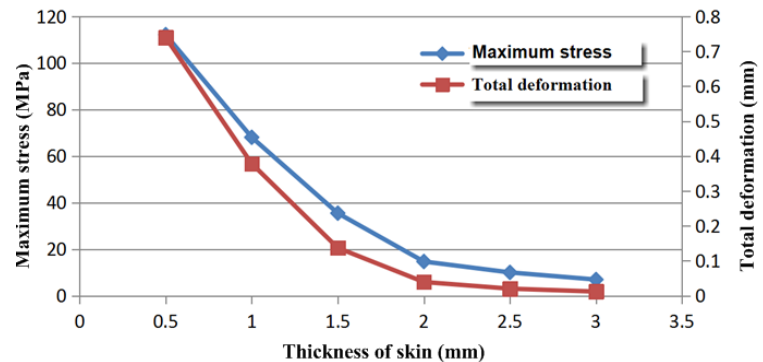
Figure 7. Stress and strain of skin under load of 500 N.